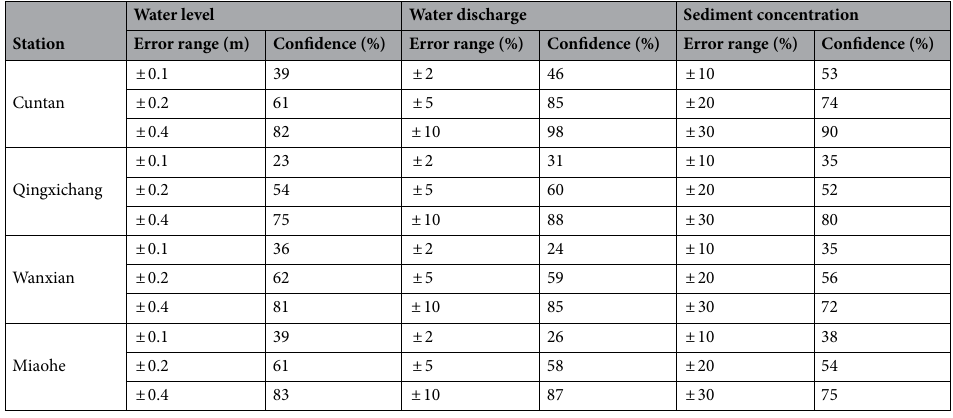
Table 3. Analysis of the verification error range of the daily water flow process in the TGR from January 1, 2008, to December 31, 2017.